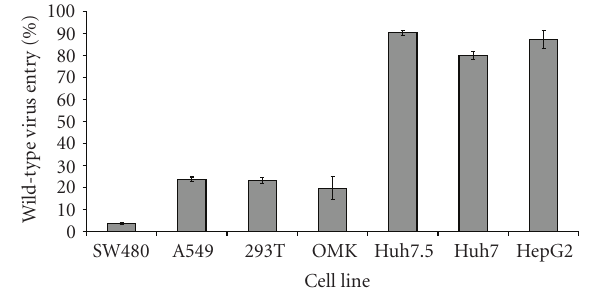
Figure 8: HVS mORF51 infection rates shown as a percentage of HVS-GFP-BAC infection in di ff erent cell types. Each virus, at an m.o.i of 2, was used to infect a panel of cell lines. GFP fluorescence (used as a marker of infected cells) was measured by flow cytometry 48h after infection ( n = 2). All hepatocellular carcinoma cell lines (Huh7, Huh7.5, and HepG2) have an infection rate of over 80% of that observed with HVS-GFP-BAC. In the permissive OMK cell line, as well as in the A549 lung cell line and HEK 293T cells, HVS mORF51 infects only approximately 20% of the number of cells infected with HVS-GFP-BAC. HVS mORF51 infects colorectal cancer cell line SW480 most ine ffi ciently, producing an infection rate just of 4% compared to